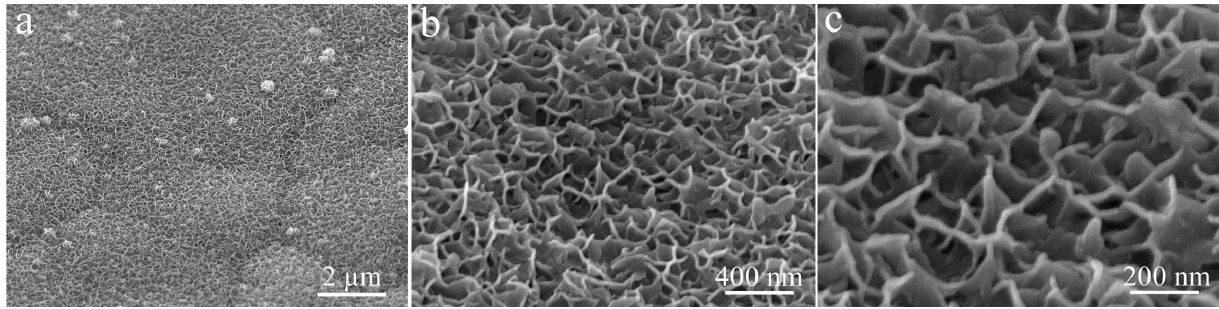
Figure 11. Low ( a ) and high ( b , c ) magni fifi cation SEM images of NCS grown on CF at di ff erent magni fi cations.